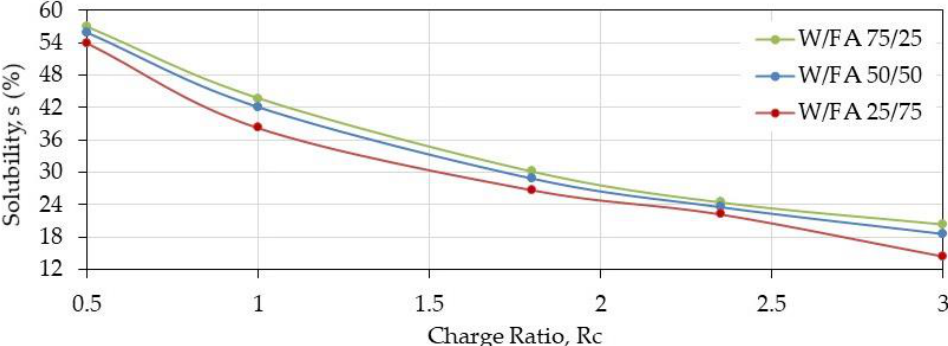
Figure 2. Solubility of PEC films at pH = 7.4 after thermal treatment as a function of charge ratio